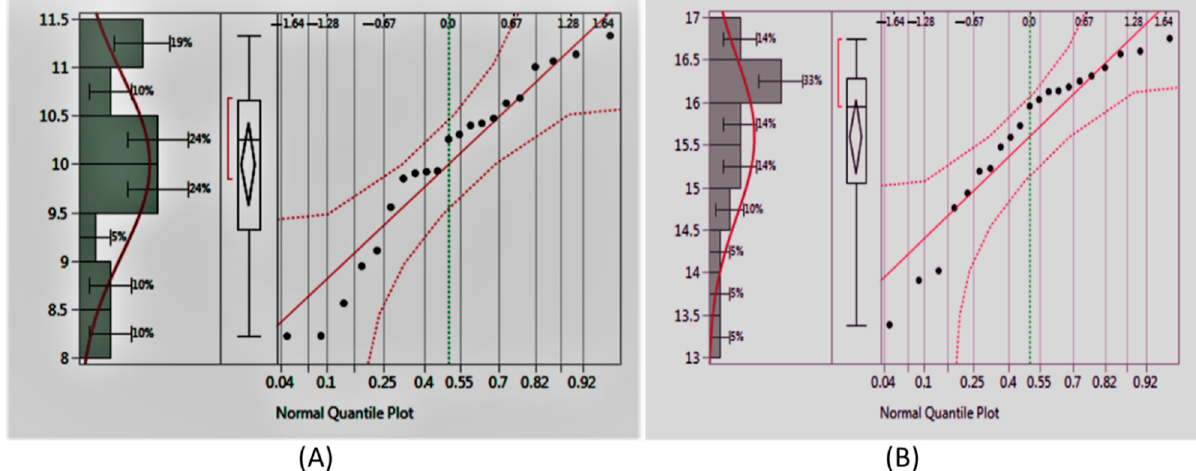
Figure 3. The Box and normal quantile plot showing results of normal distribution of maize-wheat system grain yield